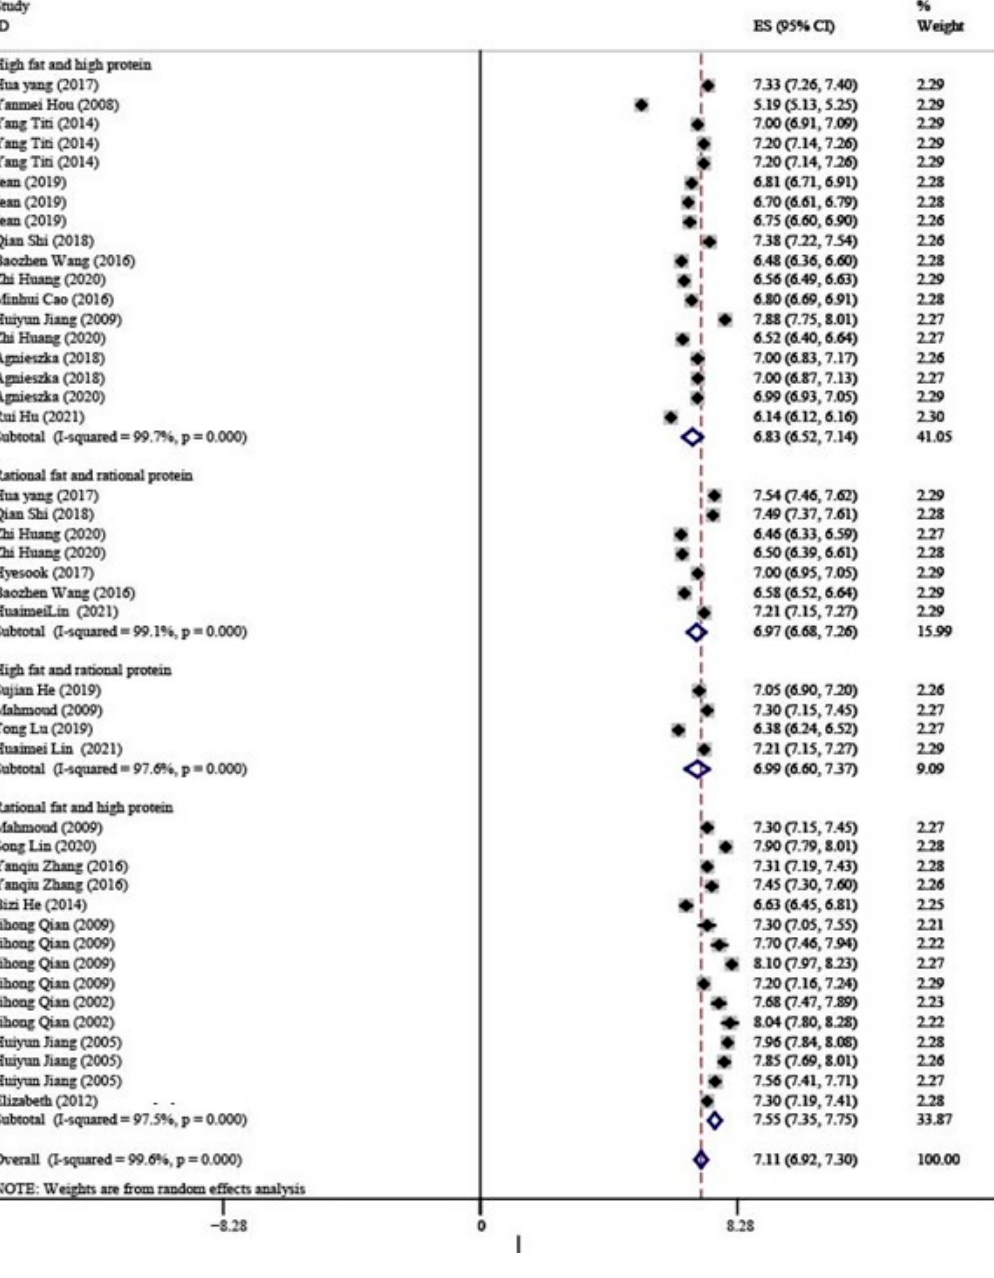
Figure 4. Forest map shows the mean values of lactose contents in breast milk at four different die ‐ tary patterns [26–61].